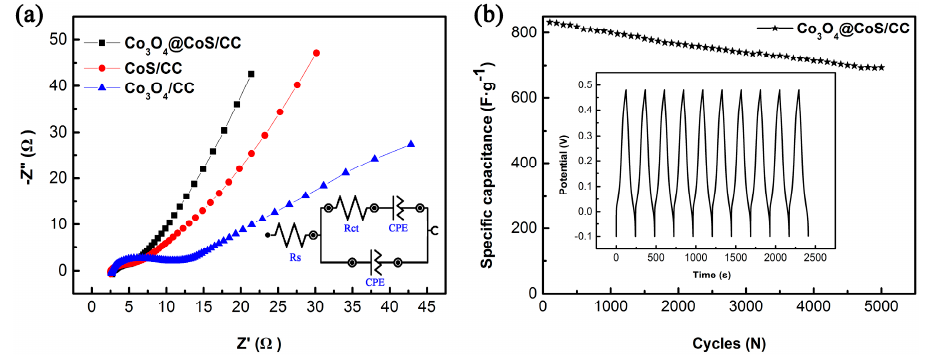
Figure 8. ( a ) electrochemical impedance spectroscopy (EIS) curves of CC, Co 3 O 4 /CC, and Co 3 O 4 @CoS/CC electrodes with insets showing the equivalent circuit diagram fitting the EIS; ( b ) Cycling stability of theCo 3 O 4 @CoS/CC electrode at the current density of 5 A·g − 1 for 5000 charging-discharging